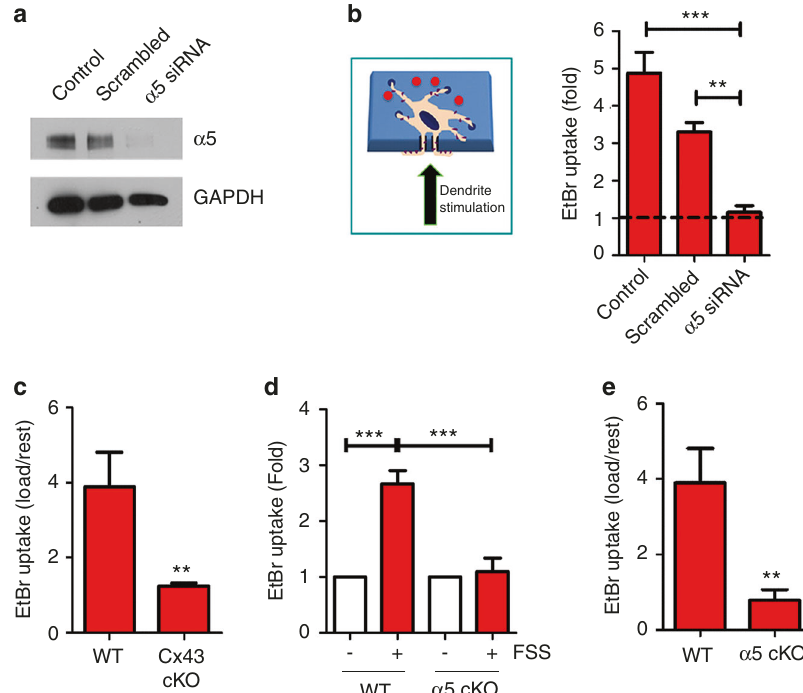
Fig. 4 Mechanical stimuli at osteocyte dendritic processes are transmitted and open HCs through integrin α 5. a Knockdown of integrin α 5 expression by siRNA. MLO-Y4 cells were treated with α 5 siRNA, scrambled RNA, or vehicle control for 48 h. Cell lysates were immunoblotted with an anti- α 5 or GAPDH antibody. b Integrin α 5 siRNA inhibits HC opening induced by mechanical loading on dendritic processes. Cells pretreated with α 5 siRNA, scrambled RNA or a nontreatment control were mechanically stimulated by dropping 50 μ mol·L − 1 EtBr solution on the dendritic process (bottom) side of the fi lter (left panel). The extent of EtBr uptake was quanti fi ed on the cell body side of the transwell fi lter. The basal uptake is indicated by the dashed line. α 5 siRNA versus the control and scrambled RNA-treated group. All data are presented as the mean ± SEM. n = 3. ***, P < 0.001, and **, P < 0.01. c De fi ciency of osteocytic Cx43 in cKO mice attenuated the opening of Cx43 HCs by mechanical loading in situ. Tibial compression was conducted in WT and Cx43 cKO mice, and Evans blue was intravenously (IV) injected. After 2 h, the mice were perfused with PBS, and bone tissues were isolated. Evans blue uptake was evaluated by fl uorescence signals, and the intensity of dye uptake in osteocytes was quanti fi ed by ImageJ. The data are presented as the mean ± SEM. n = 3. **, P < 0.01. d De fi ciency of integrin α 5 in osteocytes isolated from integrin α 5 cKO mice attenuated the activation of Cx43 HCs by FSS. Primary osteocytes were isolated from 3-week-old WT and cKO mice and subjected to FSS for 15 min. EtBr uptake was conducted and quanti fi ed. The data are presented as the mean ± SEM. n = 3. ***, P < 0.001 . e De fi ciency of osteocytic integrin α 5 in cKO mice attenuated the activation of Cx43 HCs by mechanical loading in situ. Tibial compression was conducted in WT and integrin α 5 cKO mice, and Evans blue was IV injected. Evans blue uptake was evaluated by fl uorescence (left panel), and the intensity of dye uptake in osteocytes was quanti fi ed by ImageJ (right panel). The data are presented as the mean ± SEM. n = 3. **, P <